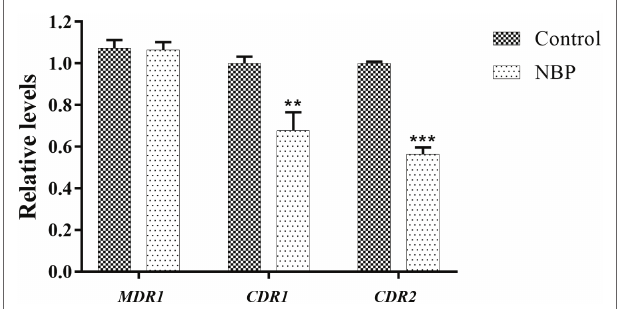
FIGURE 9 | Relative expressions of drug transporter encoding genes MDR1 , CDR1 , and CDR2 . The concentration of NBP is 32 μg/l and cells treated without NBP were served as the control group. Values represent the means ± standard deviation of three replicates. ** p < 0.01 and *** p < 0.001 compared with the respective control group (unpaired t